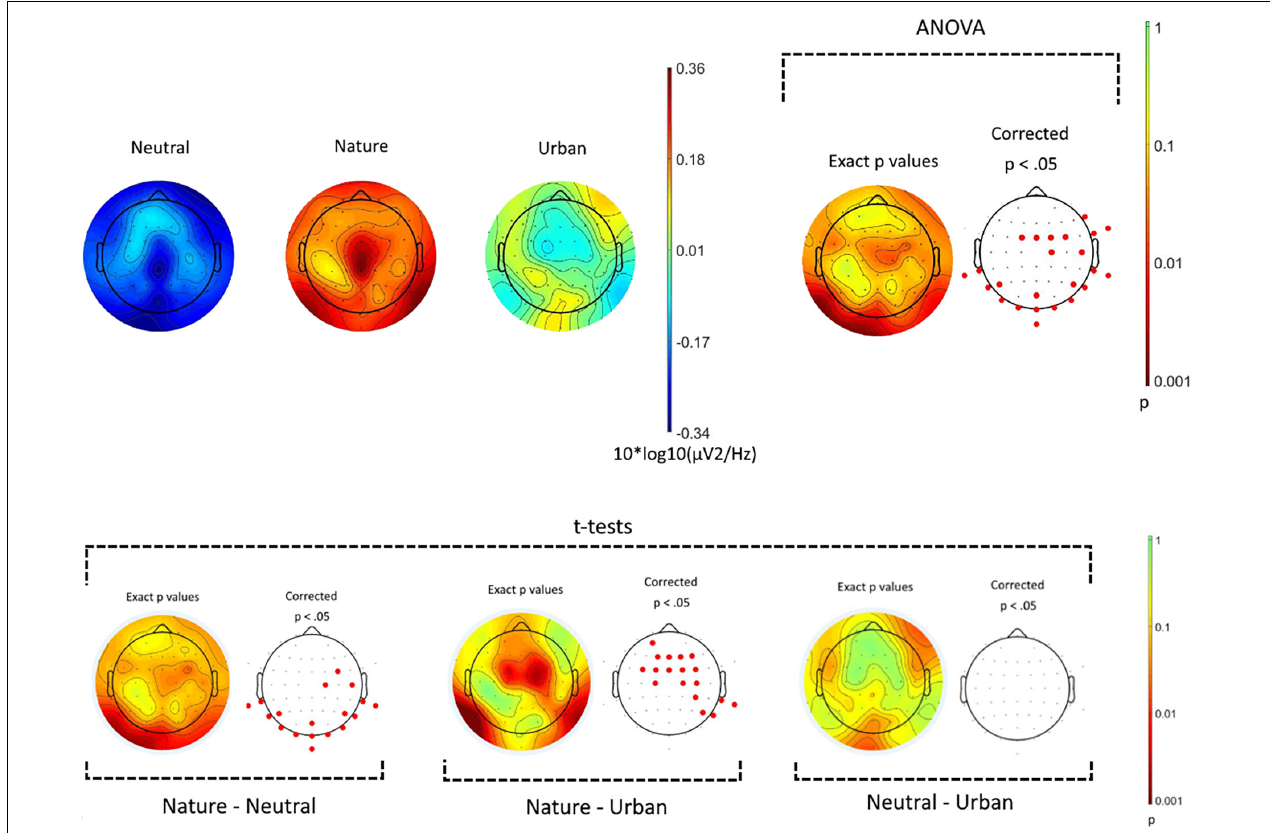
FIGURE 4 | Spatial distribution of power spectral density for early-alpha frequency band (8–11 Hz). The top panel shows the power spectral density for the three experimental conditions (neutral, nature, and urban videos). On the top-right side, the results from the ANOVA showing in red the electrodes where ps < 0.05. The bottom panel show the results of the post hoc t